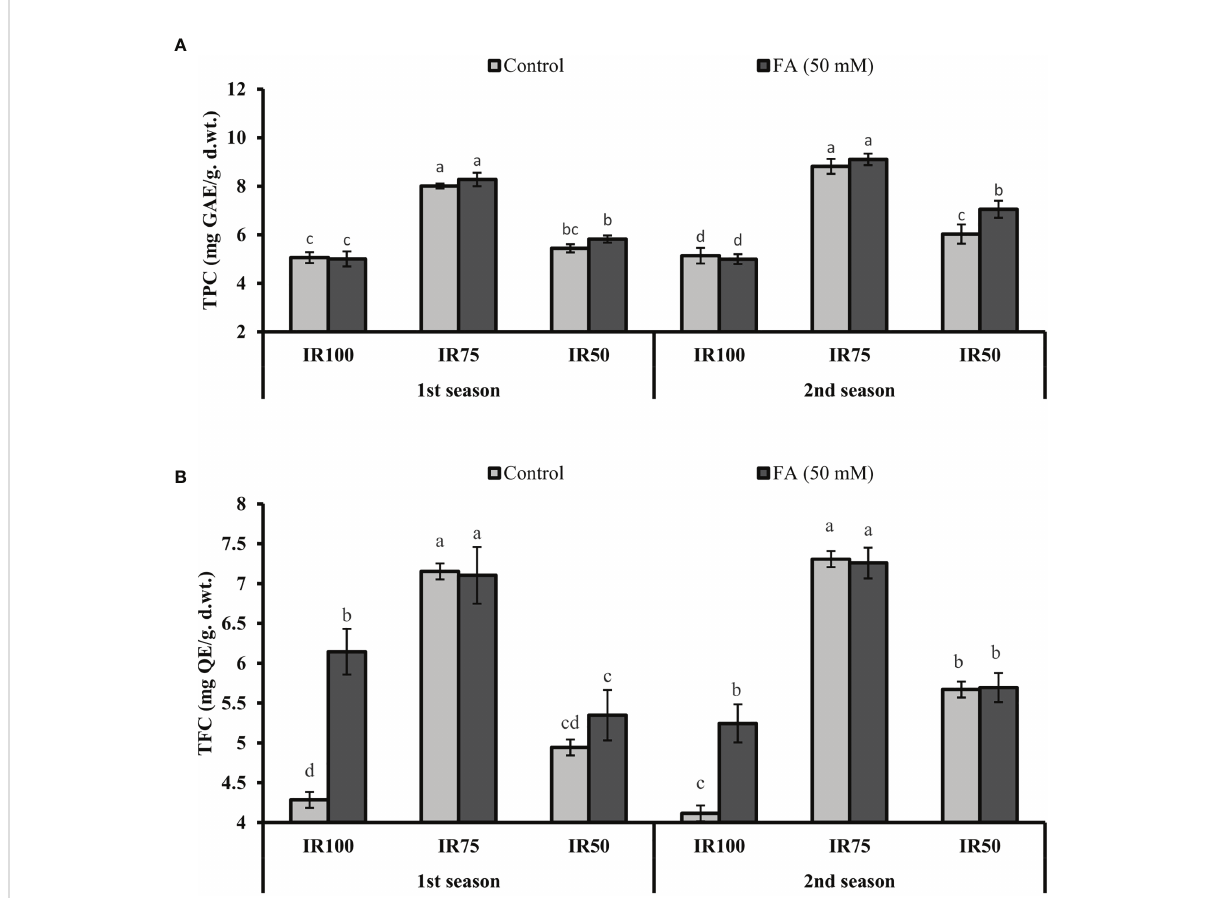
FIGURE 10 Effect of foliar application of folic acid (50 mM) on total phenolic content and total fl avonoids content in the fi rst season (A) and the second season (B) under different treatments. The graph values are the mean ± SE of four replicates. The bars exhibited with different letters show a signi fi cant difference by least signi fi cant difference ( p ≤